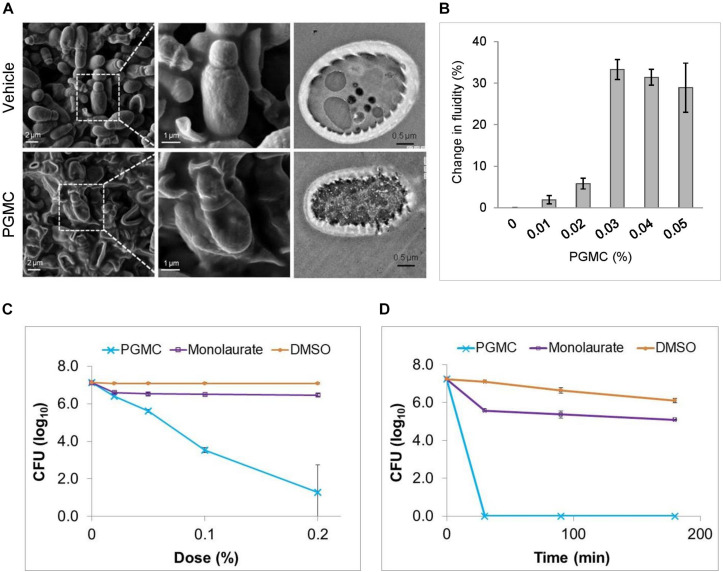
PGMC and CAP show similar antifungal activity. (A) SEM images of vehicle-treated M. furfur cells (left, upper panel) and those of PGMC treated (left, lower panel) cells. Images on the middle panels are magnifications of a group of cells demarcated by the squares from the field shown in the left panels of SEM images. TEM image of vehicle-treated M. furfur cell (right, upper panel) and that of a PGMC (0.2%) treated cell (right, lower panel). (B) Changes in membrane fluidity of DPH labeled M. furfur cells exposed to increasing concentrations of PGMC for 30 min (n = 3). (C) Effect of increasing dose of PGMC or a monoester of LRA (monolaurate) on M. furfur. Cells in broth were treated with the fatty acid monoesters at the indicated concentrations (0.02, 0.05, 0.1, and 0.2%) for 30 min. CFUs were counted 48 h after plating. (D) Effect of increasing duration of exposure of M. furfur to PGMC or monolaurate tested at a dose of 0.2%. Cells were treated with caprylic acid or its monoester in broth and samples were plated at the indicated time points (30, 90, and 180 min). CFUs were enumerated 48 h after plating. Data represent the average of at least three biological replicates with error bars indicating standard deviation.